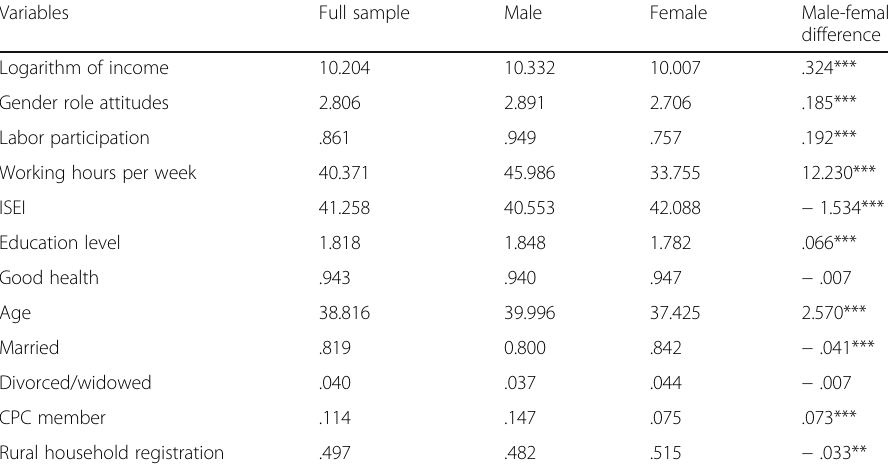
Table 1 Summary statistics for